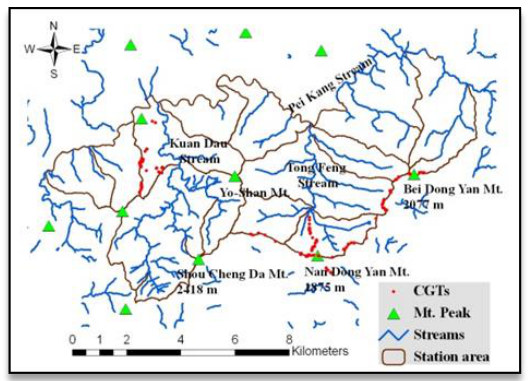
Figure 1. Location map of the study